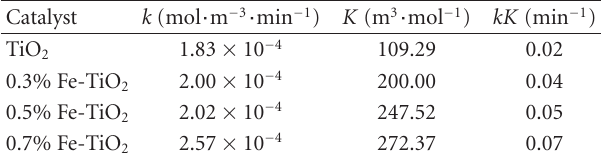
Figure 1: Schematic diagram of the photoreactor used for the degradation of toluene. 1: sampling port, 2: glass reactor, 3: coated stainless steel impeller, 4: UV-LED light source, 5: motor, 6: power supply. Table 2: L-H parameters obtained in the photocatalytic degrada- tion of toluene. Catalyst